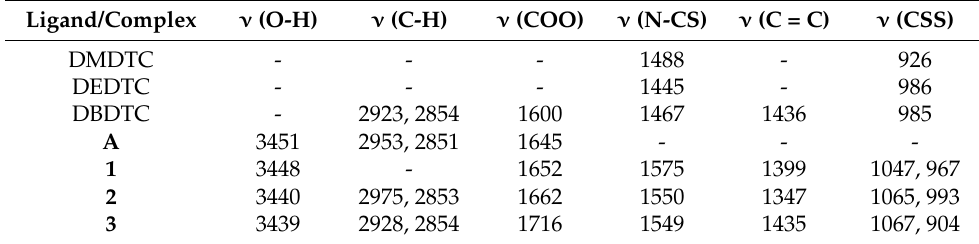
Table 1. IR frequencies (cm − 1 ) of free ligands and their